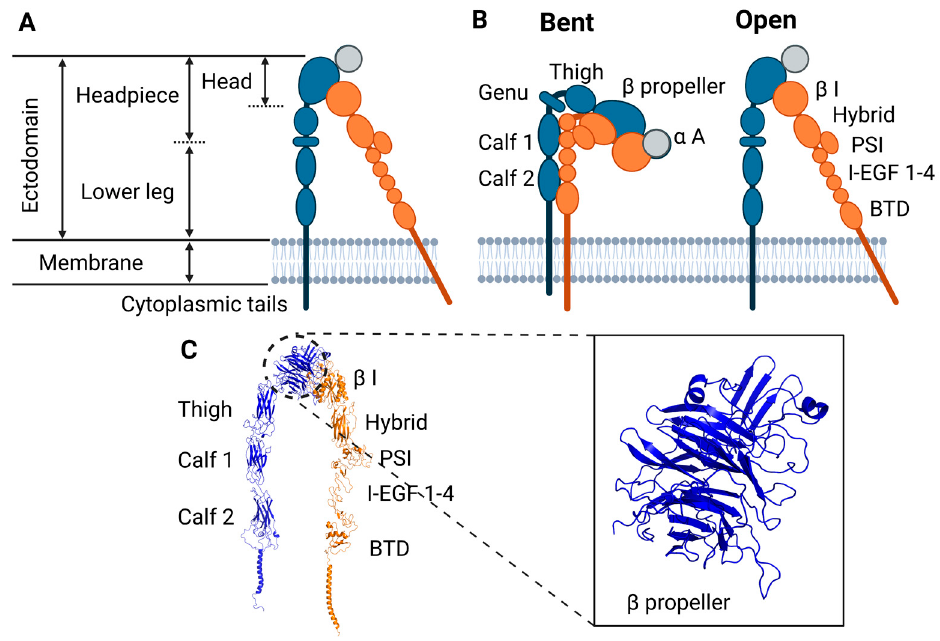
Figure 1. Schematics of integrin in bent and extended conformations. ( A ). Integrins are non-covalent heterodimers comprised of an α subunit (blue) and a β subunit (orange). Both subunits include an extracellular region, or ectodomain, which includes the headpiece and legs, a transmembrane helix, and a cytoplasmic domain. ( B ). Bent and extended conformations of integrin. The α subunit (blue) consists of an N-terminal, a β -propeller, a thigh domain, two calf domains, transmembrane α helix, and cytoplasmic α tail. The α A domain is represented in gray. The β subunit (orange) consists of an N-terminal β -I domain followed by the hybrid, the plexin-semaphorin-integrin domain (PSI), four cysteine-rich epidermal growth factor (EGF) modules (I-EGF) 1-4, β -Tail domain (BTD), trans- membrane β helix, and cytoplasmic β tail. ( C ). Ribbon representation of extended-open α IIb β 3 from cryo-EM reconstructions [24]. Secondary structure elements of the α (blue) and β (orange) subunit are shown. The α subunit seven-bladed β -propeller domain is represented in the zoomed section.